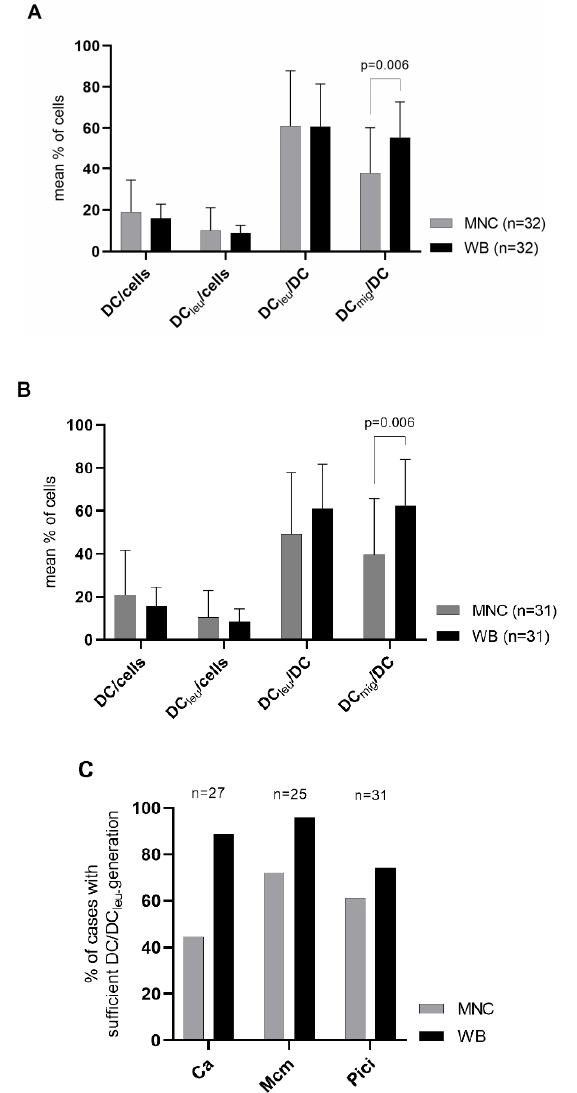
Figure 2. DC/DC leu -generation from leukaemic WB and MNC with standard DC/DC leu -generating protocols (Ca, Mcm, Pici). Given are the mean ± SD of DC/cells, DC leu /cells, DC leu /DC and DC mig /DC generated with all standard protocols pooled ( A ) and with the standard protocol Pici ( B ) from MNC compared to WB. Further shown are proportions of cases with sufficient DC/DC leu -generation fol- lowing the DC/DC leu -classification using standard protocols (Ca, Mcm, Pici) in MNC compared to WB ( C ). Statistically significant differences ( p values < 0.05) (two-tailed t-test) are given. Table 1. Classification of DC- and DC leu -generation.